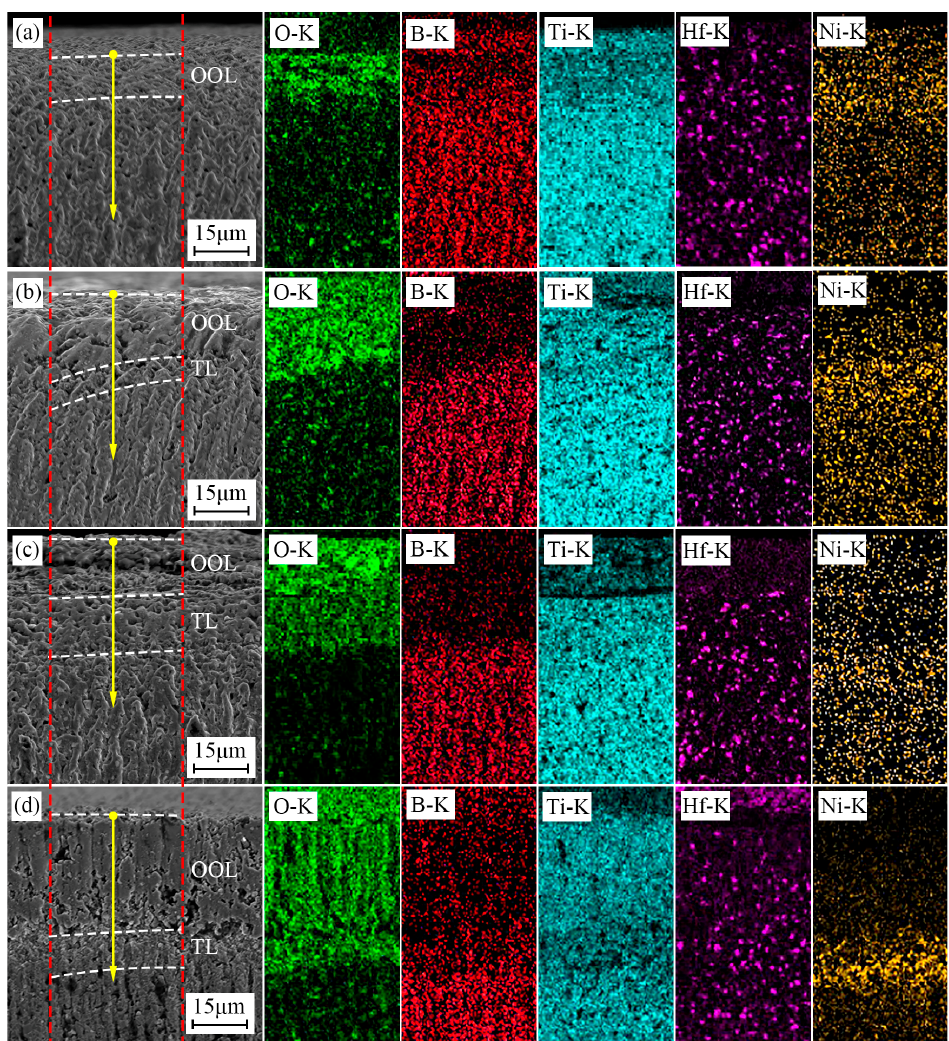
Figure 8. BSE patterns and the corresponding EDS map scan results of cross-section of TBHB at 1100 °C in different oxidation times: ( a ) 1 h, ( b ) 4 h, ( c ) 7 h, ( d ) 10 h.